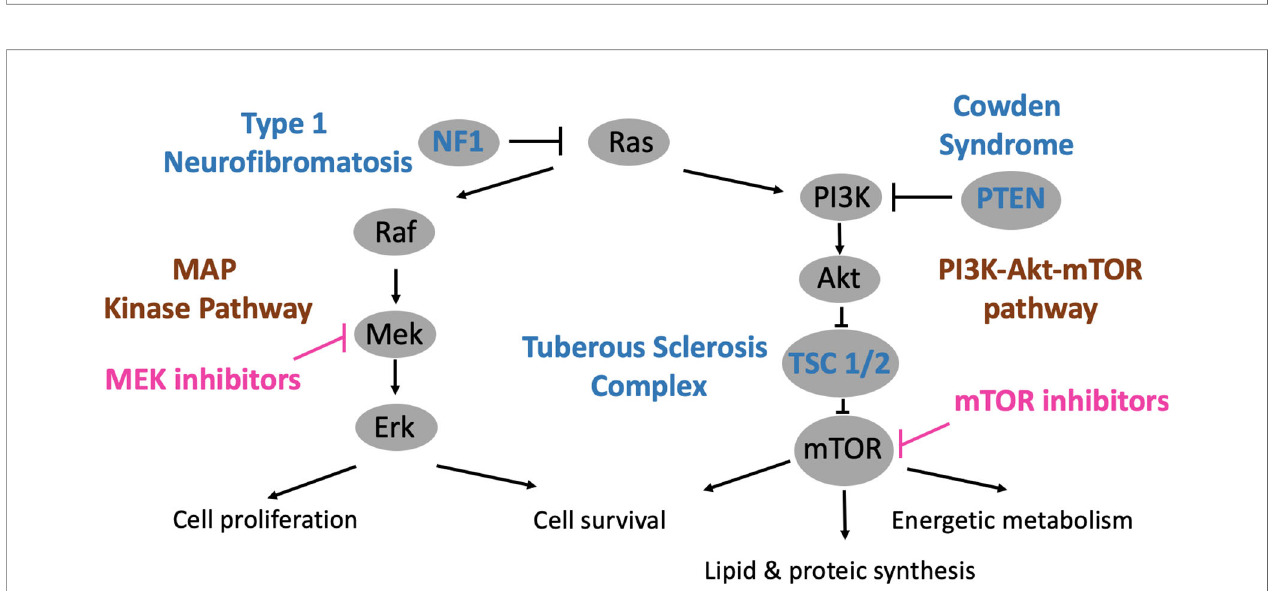
FIGURE 1 | Main tumors of endocrine glands in patients diagnosed with phakomatoses. (TSC, tuberous sclerosis complex; VHL, von Hippel-Lindau disease; NF1, neuro fi bromatosis type 1; CS, Cowden